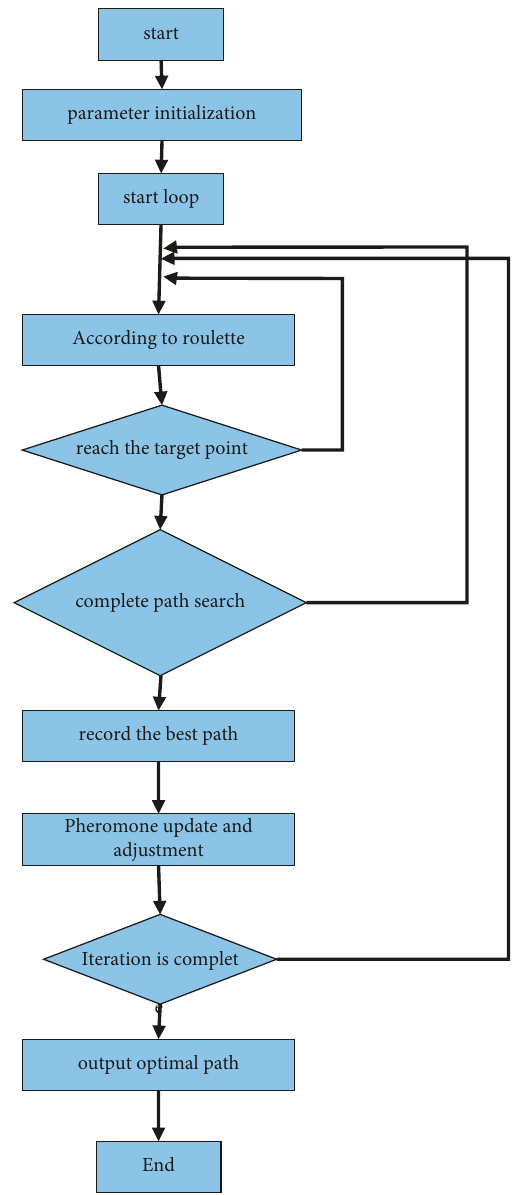
Figure 4: Flowchart of basic ant colony algorithm path planning application.